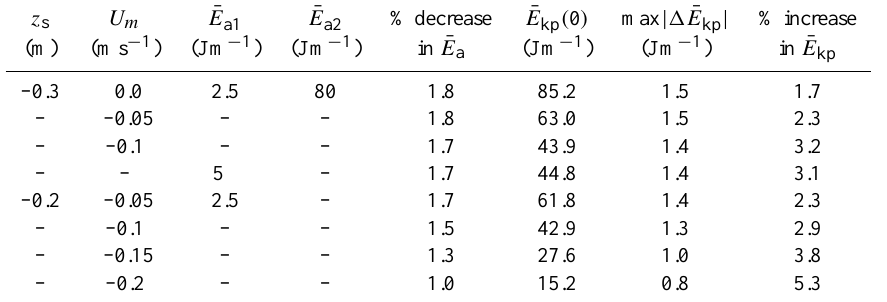
Table 1. Change in ¯ E a and ¯ E kp during the interaction of two ISWs. In all cases 1ρ = 0 . 04, (z pyc ,d pyc ) = ( − 0 . 2 , 0 . 05 ) m and d s = 0 . 03m. z s U m ¯ E a1 ¯ E a2